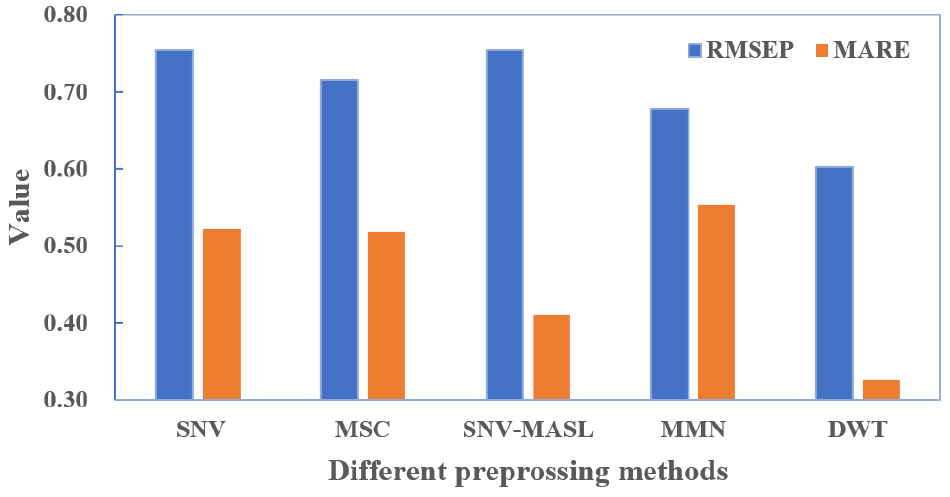
Figure 4. Effects of different preprocessing methods for paraffins. As shown in Figure 4, the RMSEP and MARE values of all pretreatment methods were lower than 0.8 and 0.6, respectively. The RMSEP value of SNV-MASL was the highest, while the MARE value was relatively small. The RMSEP value of MMN was relatively small but the MARE value was particularly high. SNV and MSC had similar effects. Among the five methods, RMSEP and MARE values of DWT were the smallest; with other methods. Thus, DWT was chosen as the method for the pretreatment of NIR spectral data. different properties are shown in Figure 5. The spectral curves of all samples clearly suggesting accurately discriminating the properties of HBO was challenging. The line of different color represented different samples. In general, five obvious absorption